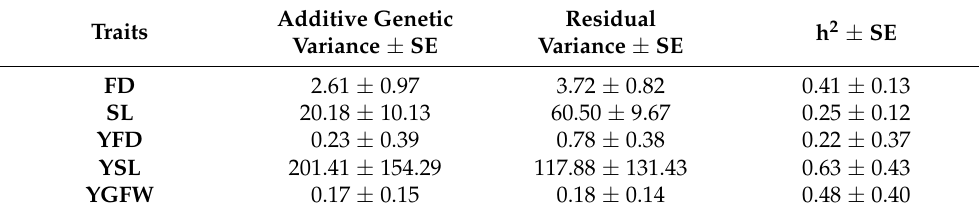
Table 2. Variance components and genomic heritability (h 2 ) estimates for traits of focus. Additive Traits